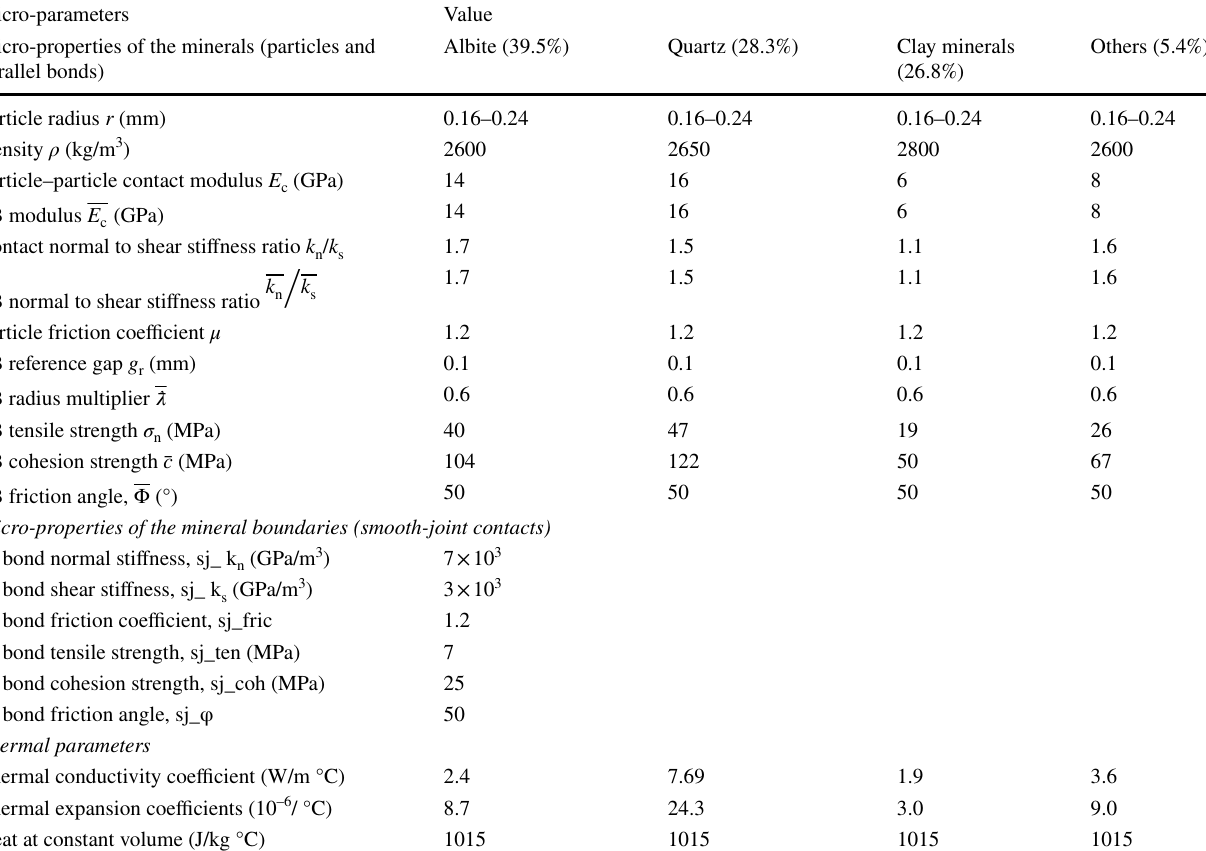
Table 1 Micro-parameters of intra-grain and inter-grain in the sandstone specimen